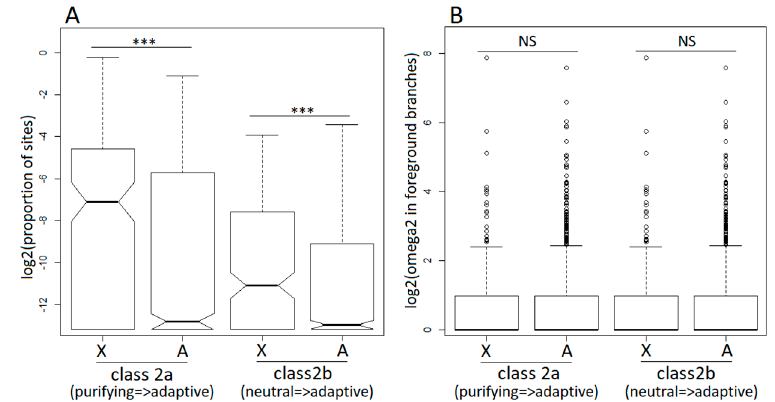
Figure 3. Branch-site model analysis of positive selection in the dioecious clade (foreground branches) for X-linked (X) and autosomal (A) genes. Class 2a and class 2b are classes of codons that switched to positive selection in the foreground branches from purifying selection (class 2a) and neutral evolution (class 2b) in the background branches. For the designations of foreground and background branches, see Figure 2A. (Panel A ) shows the proportions of sites that switched to positive selection in X-linked and autosomal genes following transition to dioecy. (Panel B ) shows the values of the omega parameter (= dN / dS ) for sites that switched to positive selection in the foreground branches. The significance of the difference between the distributions was tested with the Wilcoxon rank sum test (*** p < 0.001).